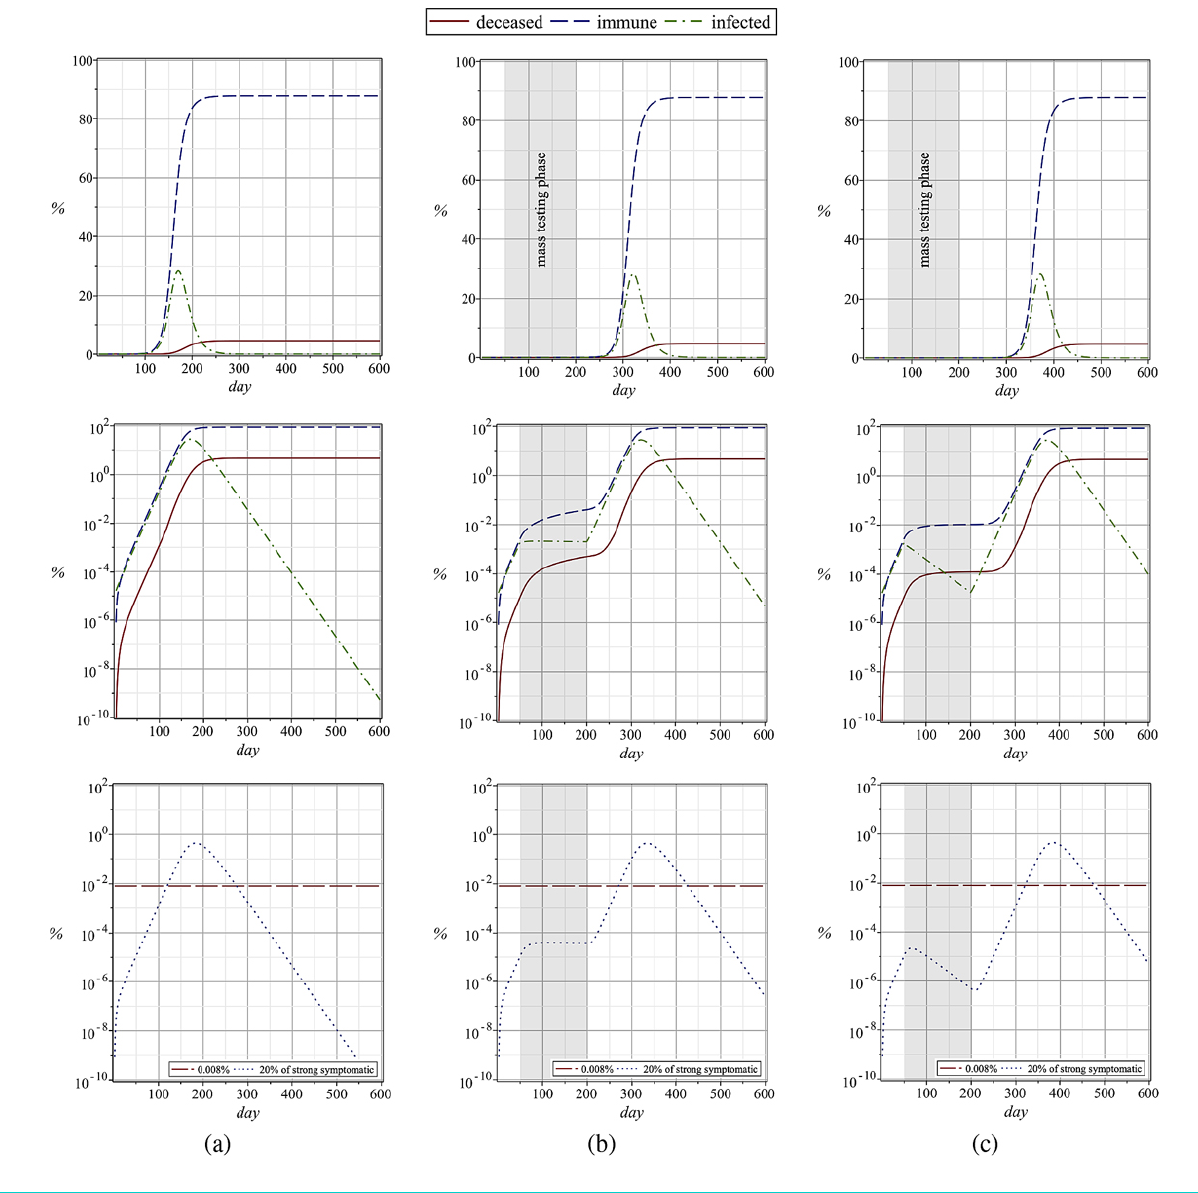
Figure 7: Mass testing from day 50 to day 200. (a) base case; (b) with a testing interval of 7.92 days with 1 day processing time (corresponding to a reproduction number of 1); (c) with a testing interval of 2.68 days with 1 day processing time (reproduction ), dash-dotted lines the infected ( ) and solid lines number of 0.7). Dashed lines represent the immune ( the deceased ( ) populations, on the upper panel with linear and in the middle panel with logarithmic scaling. The lower 𝑖𝑖𝑢𝑢𝑢𝑢𝑢𝑢𝑢𝑢𝑢𝑢 𝑖𝑖𝑢𝑢𝑢𝑢𝑢𝑢 𝑠𝑠0 𝑛𝑛 − 𝑛𝑛 𝑠𝑠 𝑛𝑛 + 𝑛𝑛 panel logarithmic plot shows 20% of the strongly symptomatic population (dotted lines) together with the intensive care unit 𝑢𝑢𝑢𝑢𝑡𝑡𝑢𝑢 𝑛𝑛 capacity of 0.008% (horizontal long dashed lines). The values are in % of the initial susceptible population size and are plotted over number of days. The grey shading marks the “mass testing”